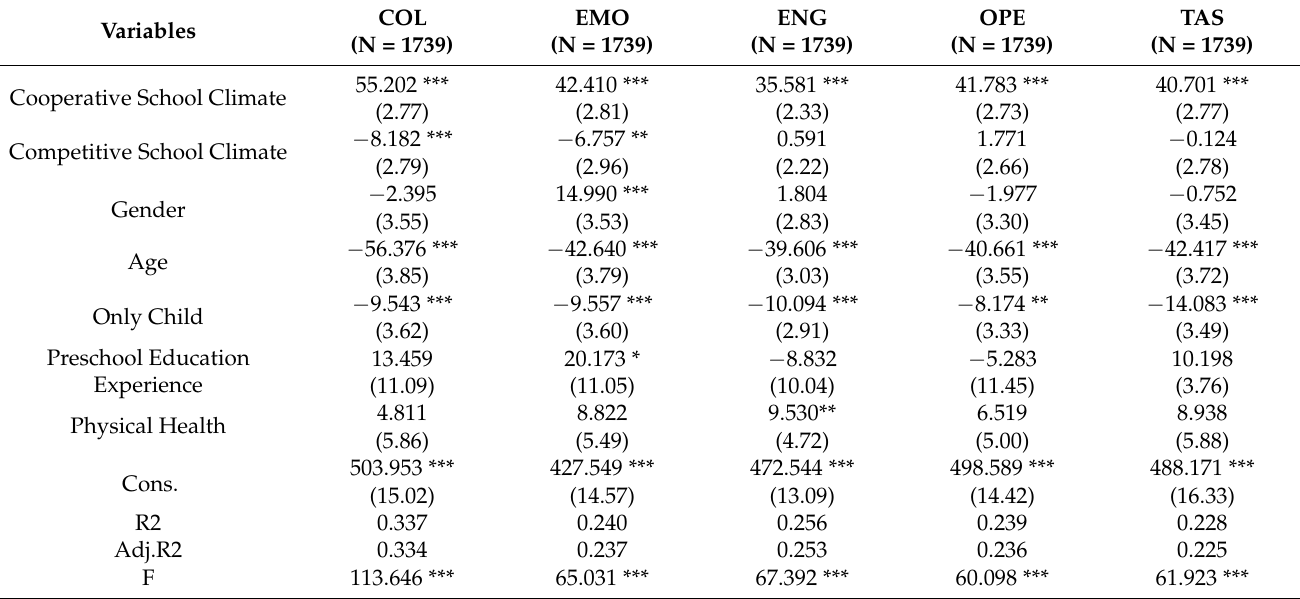
Table 2. Results of the path analysis